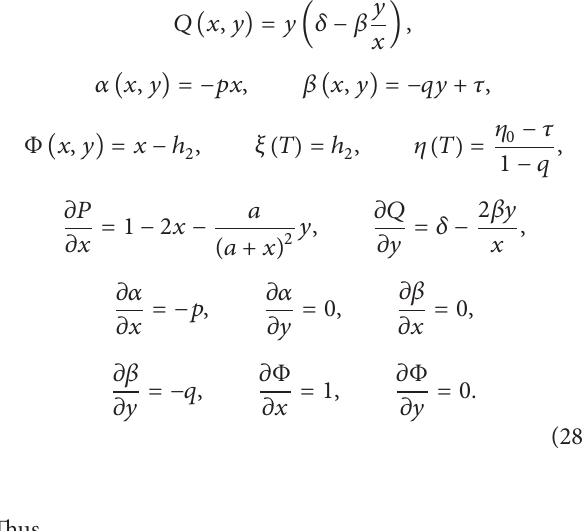
) , the image point 1